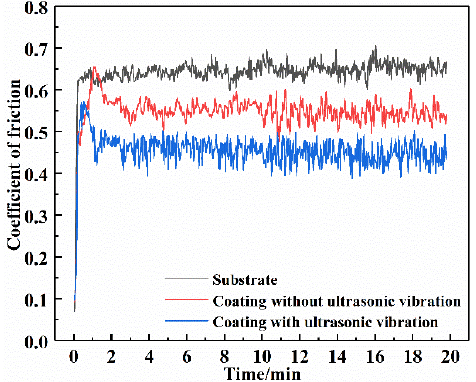
Figure 9. Wear curves of the substrate and coatings.